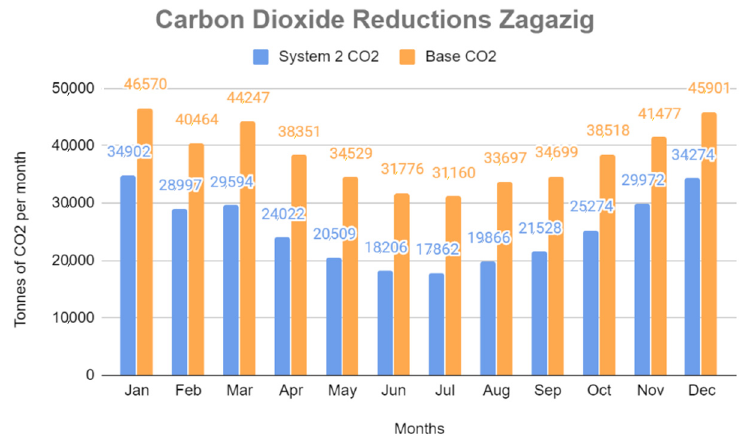
Figure 11. CO 2 emissions, Zagazig.